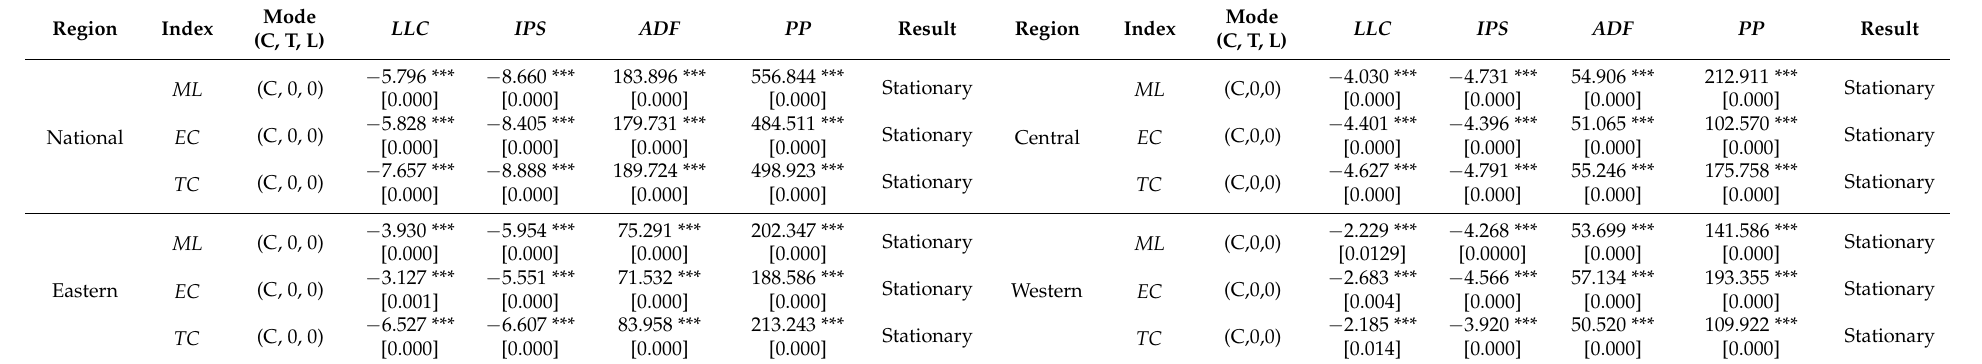
Table 7. Results of Stationarity